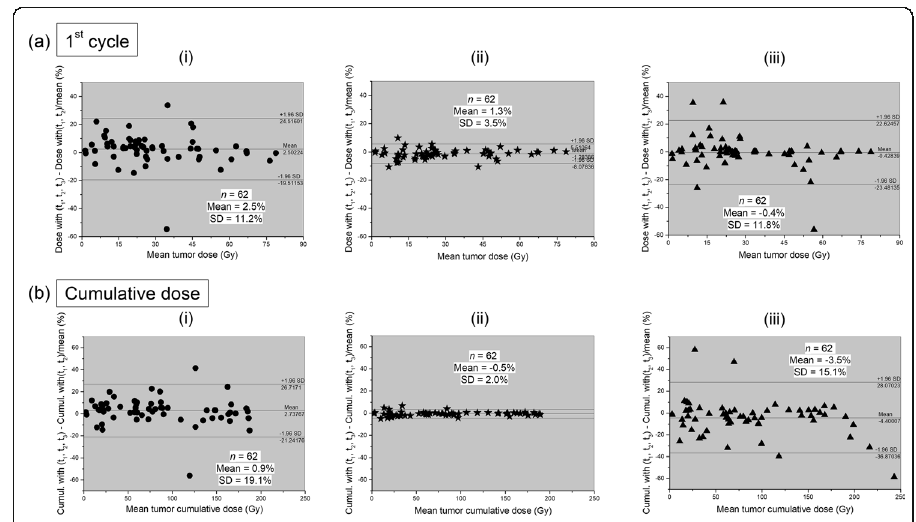
and b after completion of the treatment, computed using the standard protocol and the “ 2 time-points ” (i) ( t 1 , t 2 ),